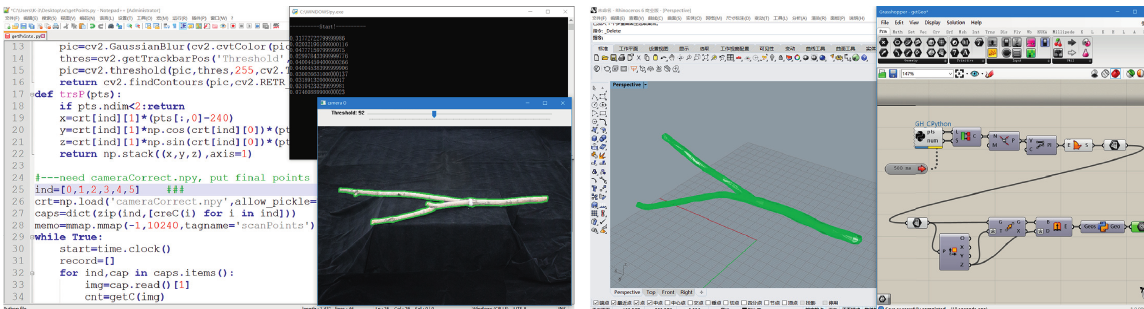
Figure 5: Scanning physical branches and building the corresponding digital models.